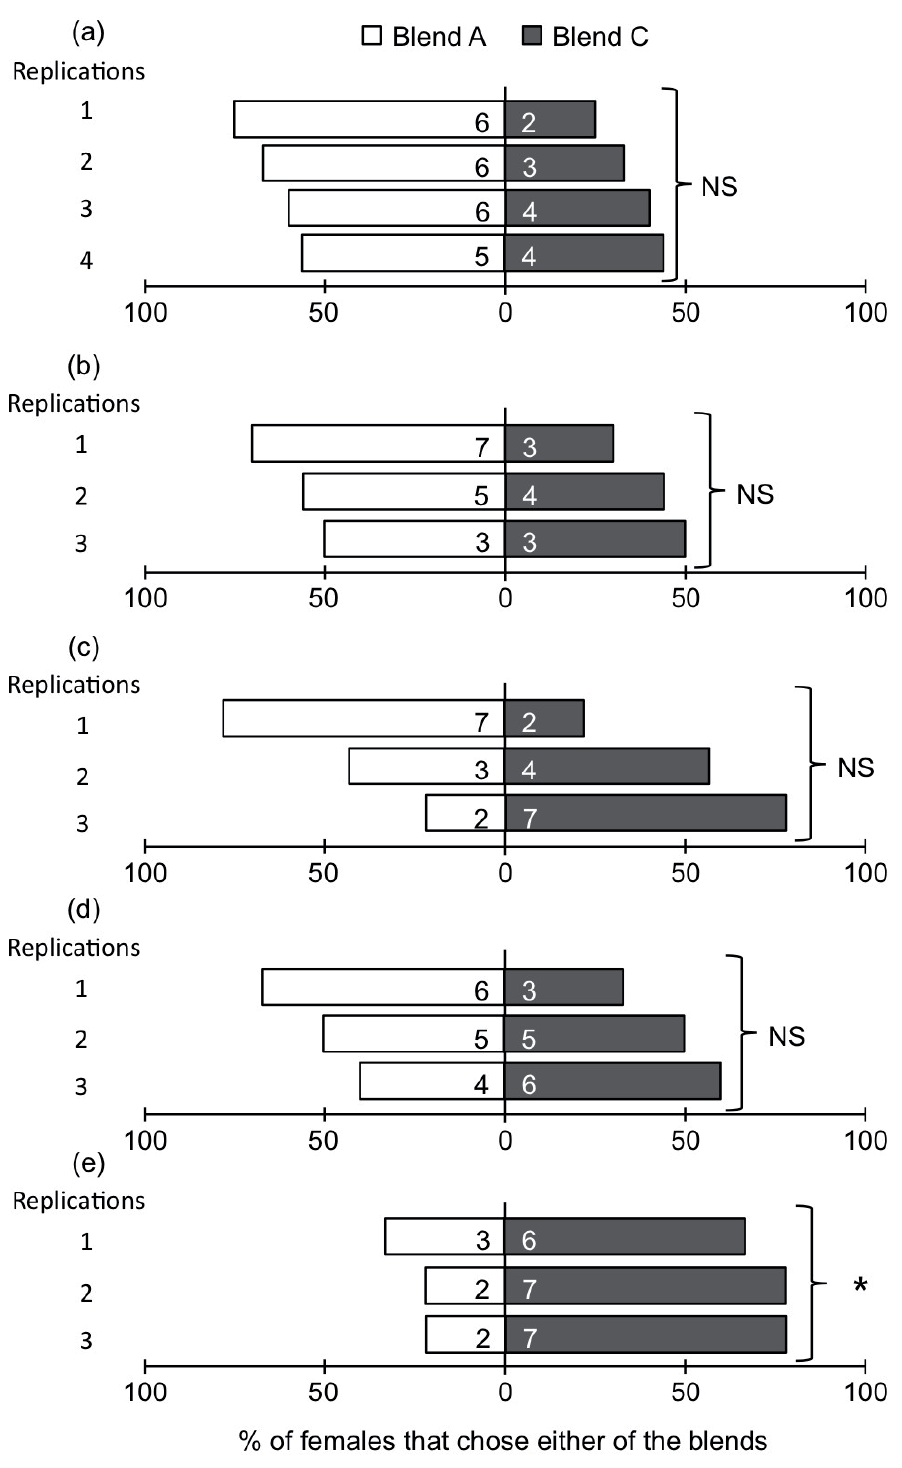
Figure 2. Responses of Cotesia vestalis to Blend A vs. Blend C. Each bar showed % of females that chose either of the blends (x axis). Numbers within bars indicate the numbers of females that landed on each plant. ( a ) Response of naïve C. vestalis . ( b ) Response of C. vestalis with oviposition experience. ( c ) Response of C. vestalis with oviposition experience in the presence of Blend A. ( d ) Response of C. vestalis with starvation experience. ( e ) Response of C. vestalis with starvation experience in the presence of Blend A. *: 0.05 > P > 0.01 , ns: not significantly different by